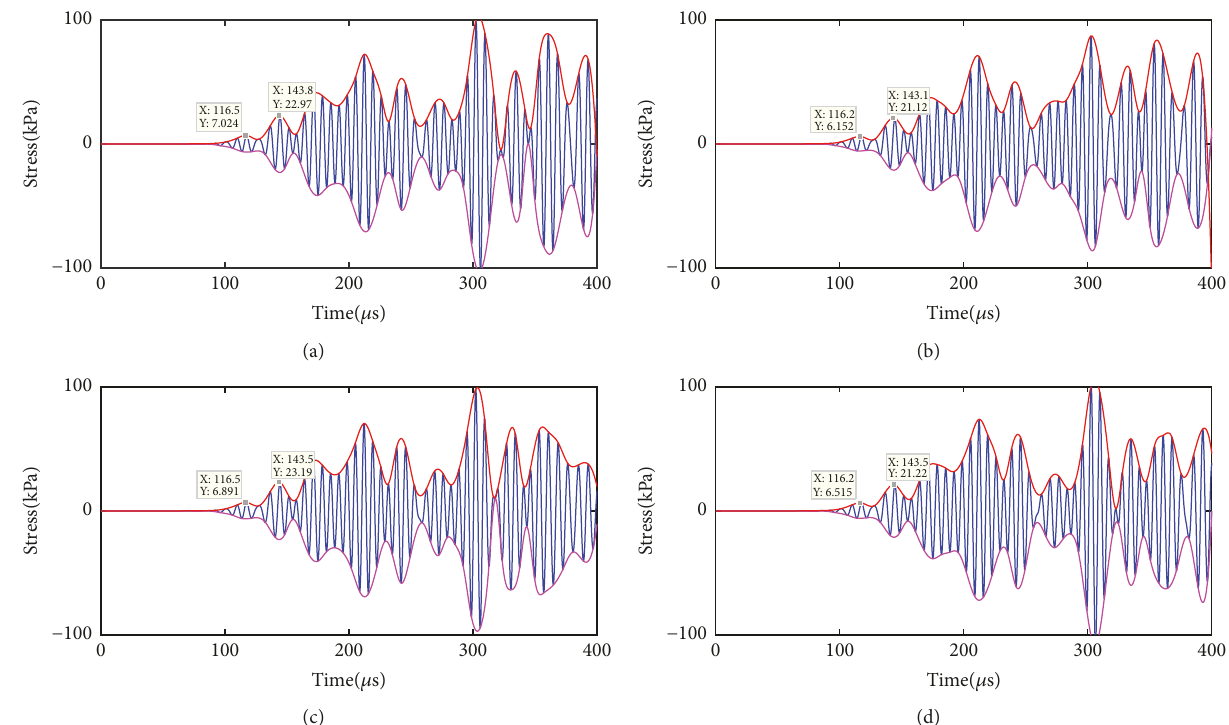
Figure 15: Collected signals of stress collection points (a) no. 1, (b) no. 2, (c) no. 3, and (d) no. 4 when the rotor rotates at 15Hz.